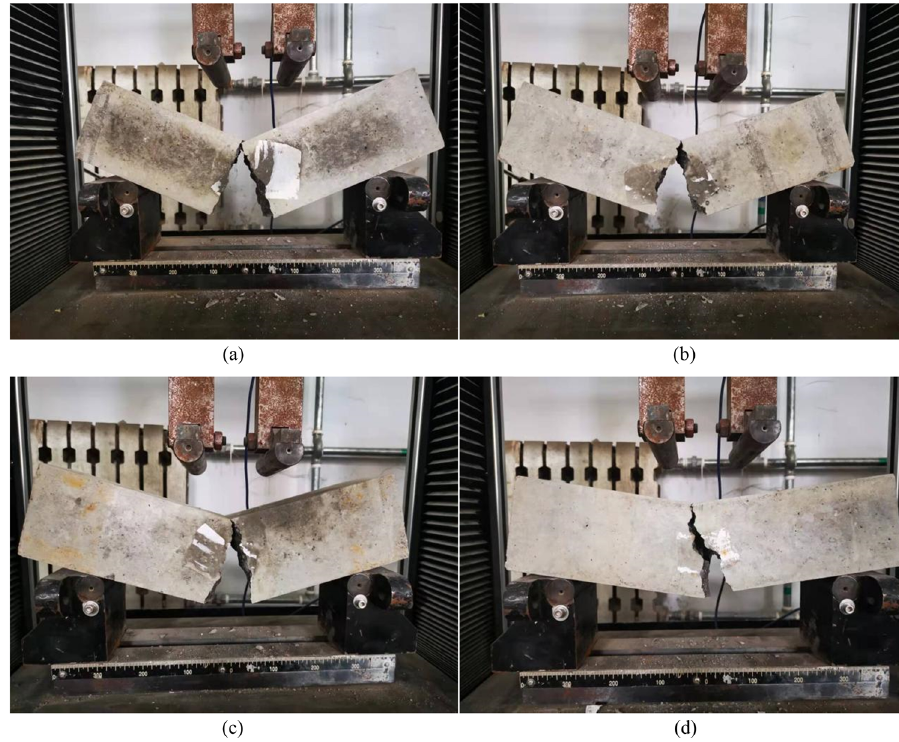
Figure 20: Flexural failure modes of RAC. ( a ) RAC, ( b ) NS2, ( c ) BF12 - 1, ( d ) BF12 -